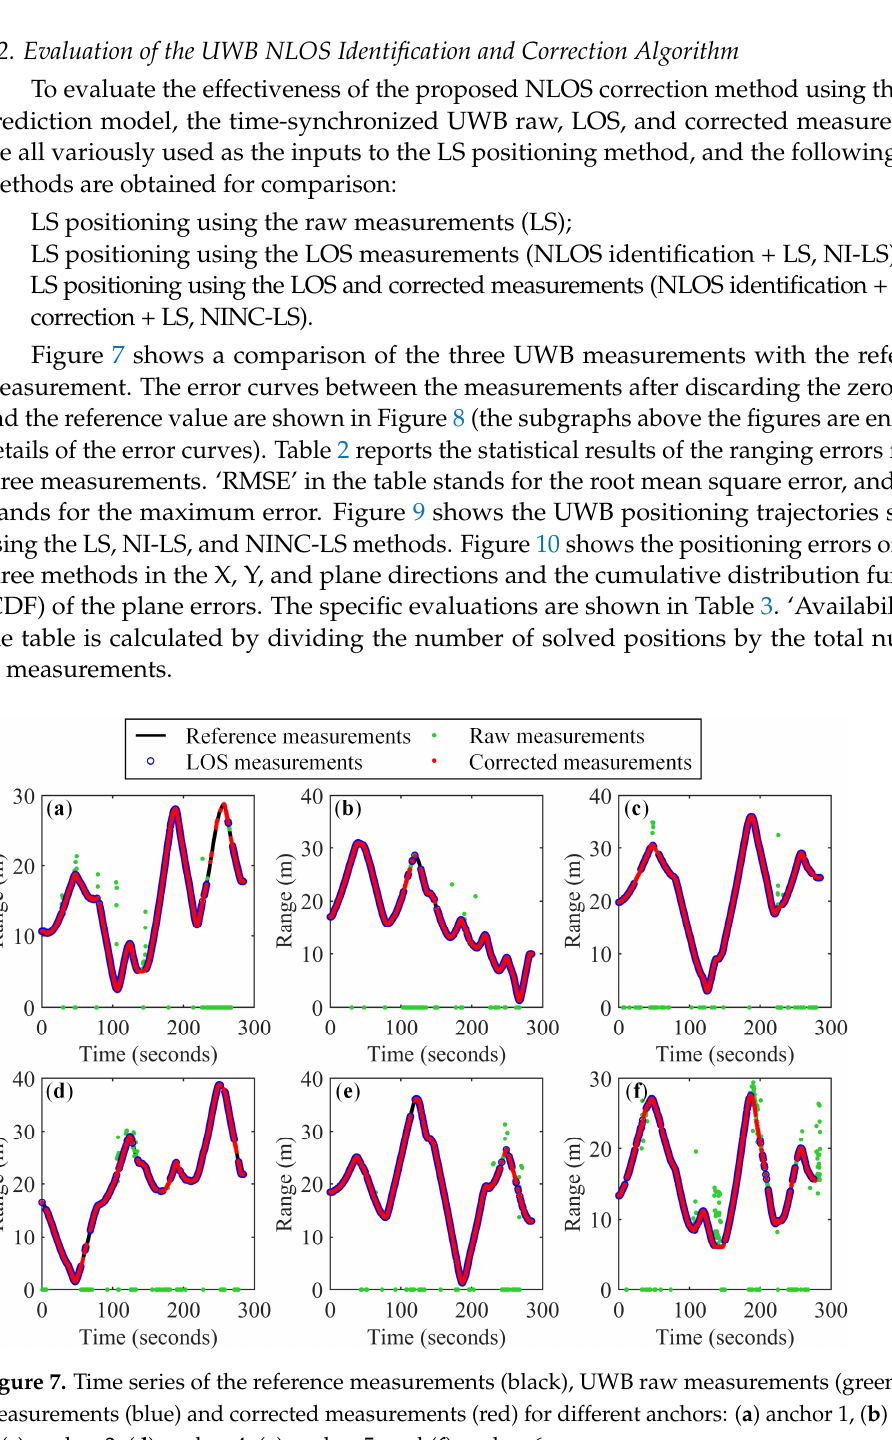
Figure 8. Ranging errors of the UWB raw measurements (green), LOS measurements (blue) and pseudo measurements (red) for different anchors: ( a ) anchor 1, ( b ) anchor 2, ( c ) anchor 3, ( d ) anchor 4, ( e ) anchor 5, and ( f ) anchor 6.